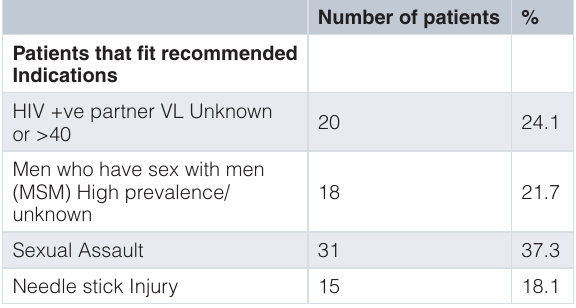
Table 2. Patients that fit into recommended indications (n=83).